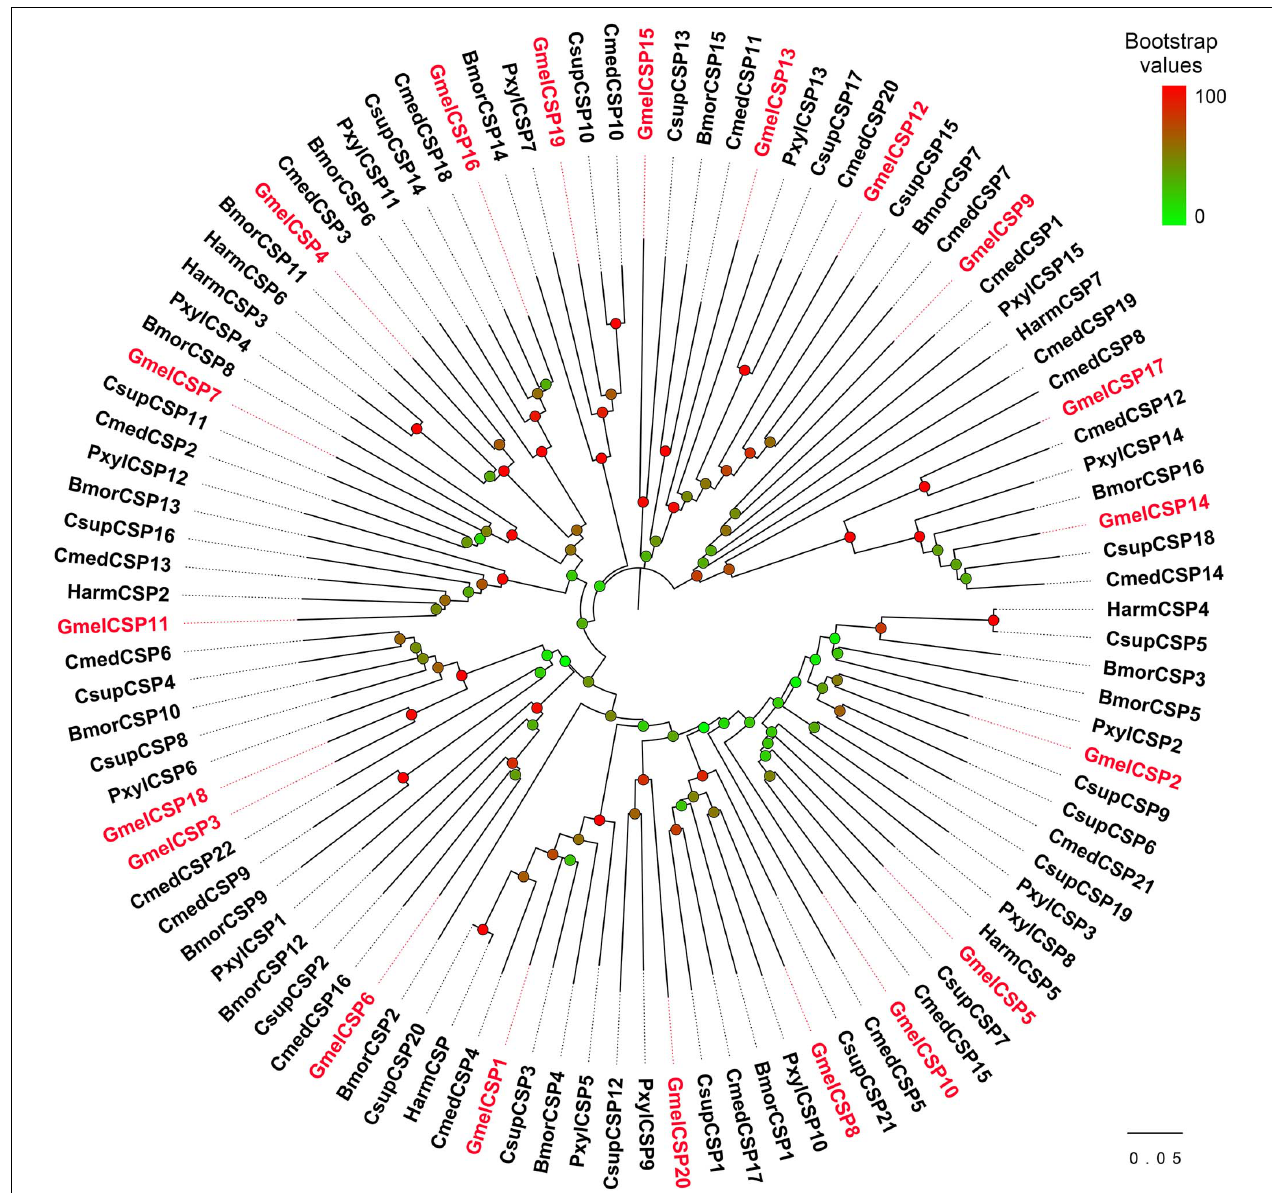
FIGURE 4 | Phylogenetic analysis of CSPs from G. mellonella (Gmel-prefix) and other lepidopterans, including Bombyx mori (Bmor), Plutella xylostella (Pxyl), Helicoverpa armigera (Harm), Chilo suppressalis (Csup), and Cnaphalocrocis medinalis (Cmed). Bootstrap values are indicated by colors from green (0) to red (100). The G. mellonella CSP s are highlighted in red. GenBank accession numbers of genes are listed in Supplementary Table 1 .